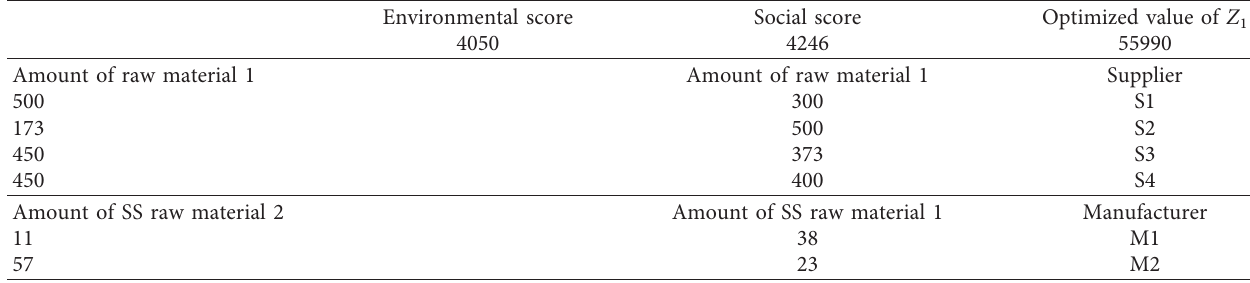
Table 5: Value of objective functions and supply portfolio by optimizing Z